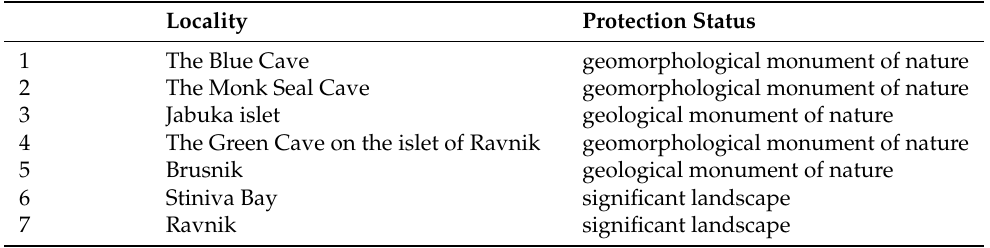
Figure 1. Map with the location of the Adriatic Sea (on the left ), along with the UNESCO Geopark Vis Archipelago area outlined in red (on the right ), showing the position of Biševo Island. Table 1. List of protected geosites in the Vis